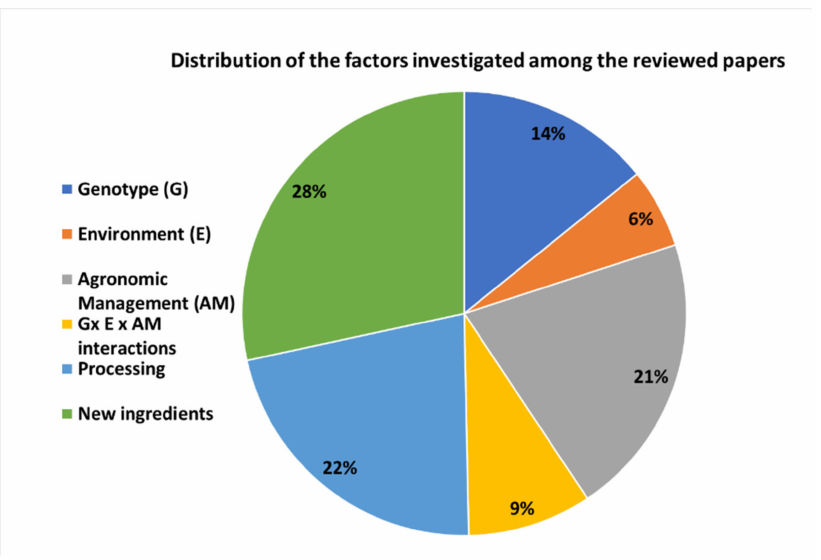
Figure 3. Distribution of the durum-wheat quality factors, as explored by the authors of the papers included in the review